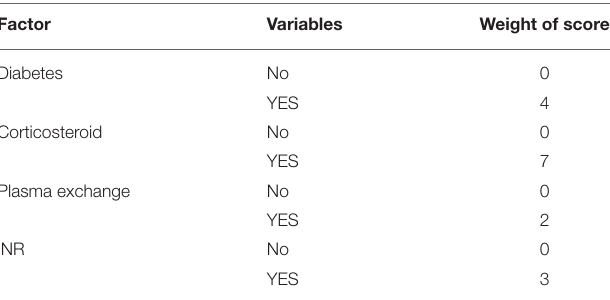
TABLE 5 | The characteristics of patients with or without antifungal prophylaxis and impact of antifungal prophylaxis in patients with different risk